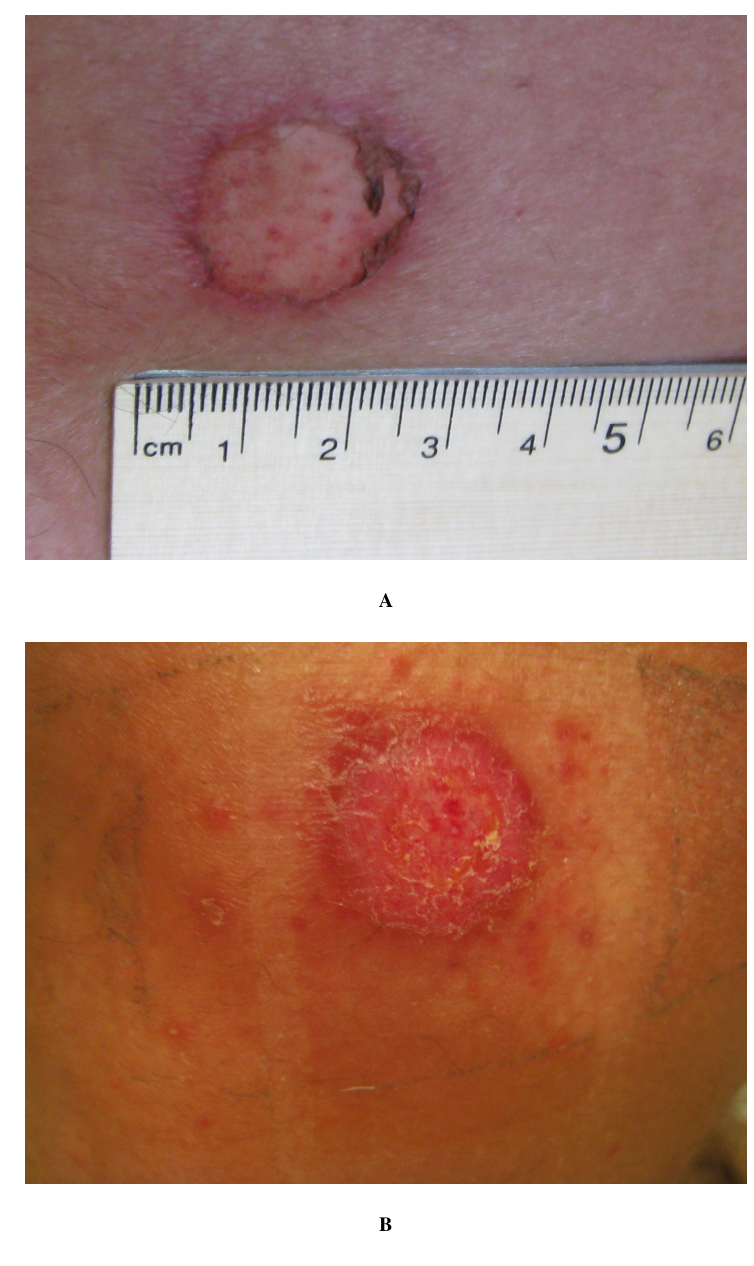
FIGURE 3. (A) The ulcer from Fig. 1 some days later, with the outer epidermis now absent with some contraction and healing at the edges; (B) 3 weeks after patch application with some general erythema and granulation tissue covering the skin